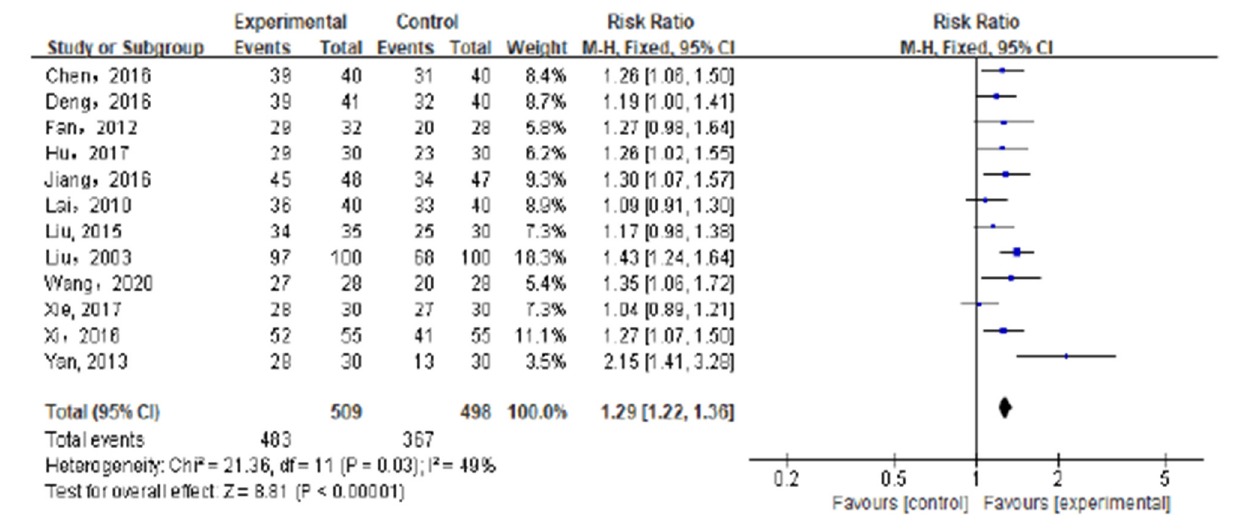
Frontiers in Public Health |